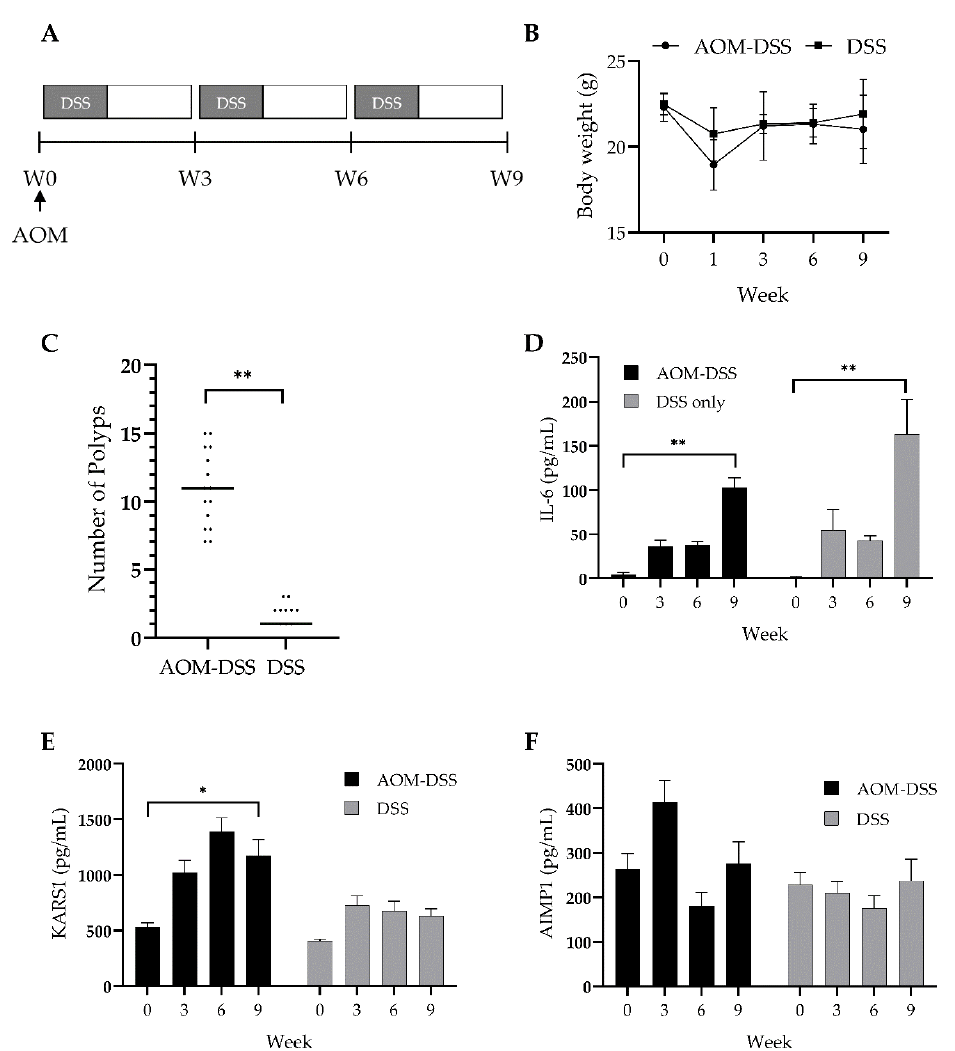
Figure 3. Plasma KARS1 level in colitis-induced colon cancer mouse model . ( A ) Schematic representation of azoxymethane/dextran sodium sulfate (AOM/DSS) treatment. ( B ) Body weight was monitored during the experiment for the AOM/DSS and DSS only treatment groups. ( C ) The number of polyps were measured. Every three weeks, interleukin 6 (IL-6) ( D ), KARS1 ( E ), and AIMP1 ( F ) levels were determined using ELISA from the plasma isolated from AOM/DSS and DSS mice. * p < 0.05, ** p < 0.0001.